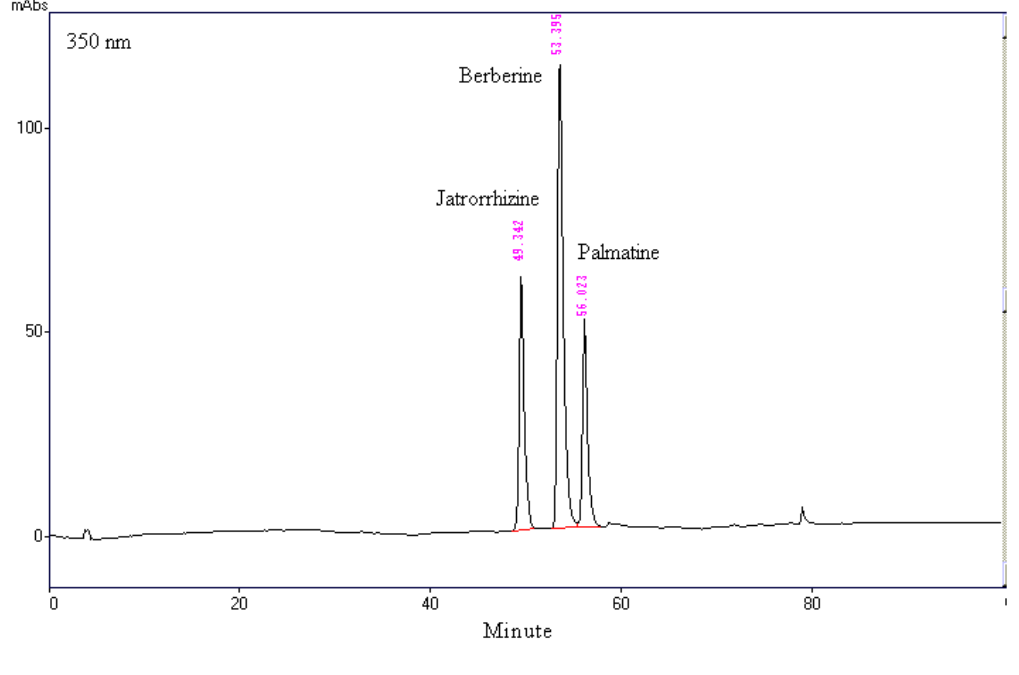
. λ = 350 nm showing the EtOH